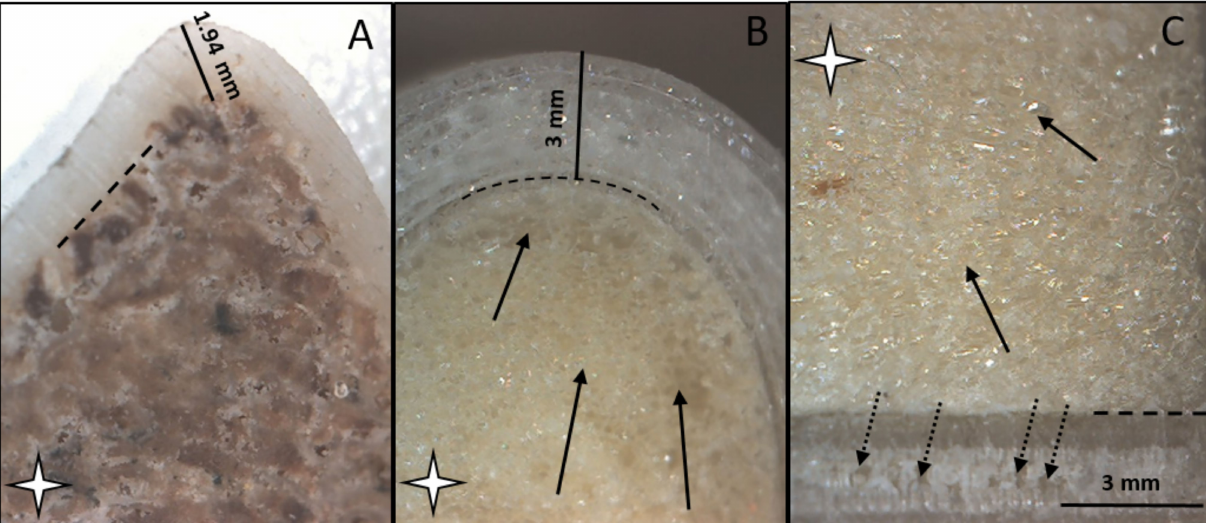
Figure 10. Image ( A ) demonstrates the structure of the demonstrational swine bone (cross section). Image ( B ) demonstrates the horizontal and image ( C ) demonstrates the perpendicular cross-section of the fabricated bone model. The black lines represent the outer, cortical parts, which is measured as 1.94 mm in case of the swine bone, and 3.00 mm in case of the 3D printed model. The white star indicates the medullar part of the bone and the simulated medulla of the model. The dashed black lines represent the transition between cortical and medullar parts. The black arrows indicate the porous structure of the model, made of polyurathane. Pointed black arrows point to the interlayers space, which demonstrates the 50% infill density of the cortical part. All images were made with 35x